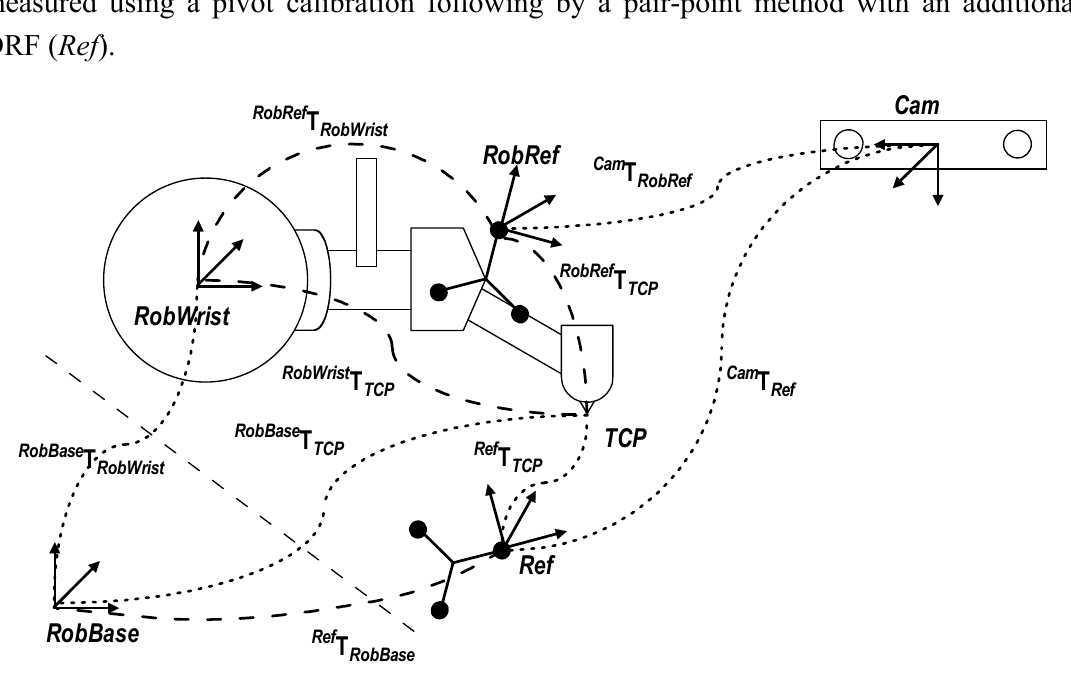
first the position of the TCP is RobWrist